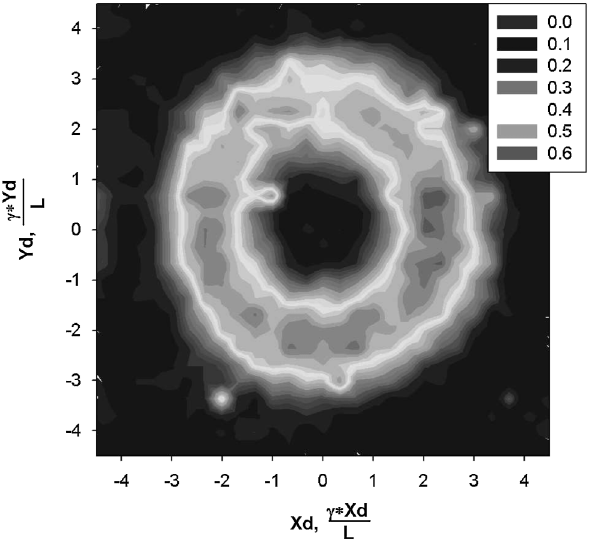
FIG. 10. Both polarization components of OTR spatial distri- bution for a 609 (cid:7) 28 nm filter from a flat